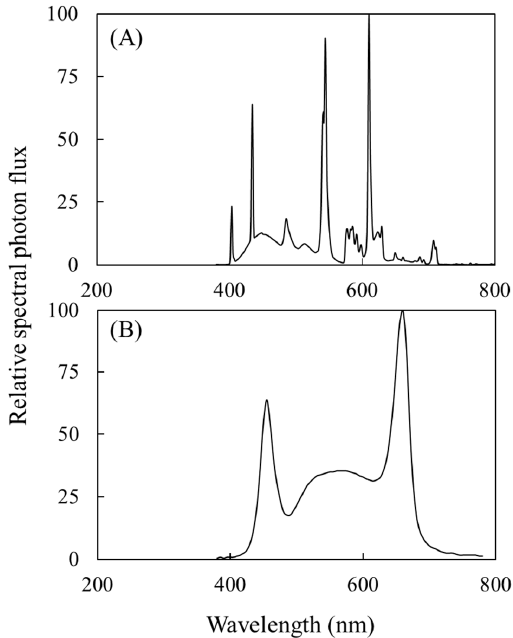
Figure 1. The relative spectral photon flux of ( A ) cool white fluorescent lamps and ( B ) LED lights. The wavelengths of light sources were recorded at 380–800 nm with a spectrometer. All treatments were performed at 7 days after transplanting (28 DAS) into the culti- vation room, so that the lettuce seedlings were well adapted to the environment of the cultivation room. The treatments were divided into four groups: (1) The control group, in which the plants were grown in a nutrient solution with water sprayed on the leaf surface;